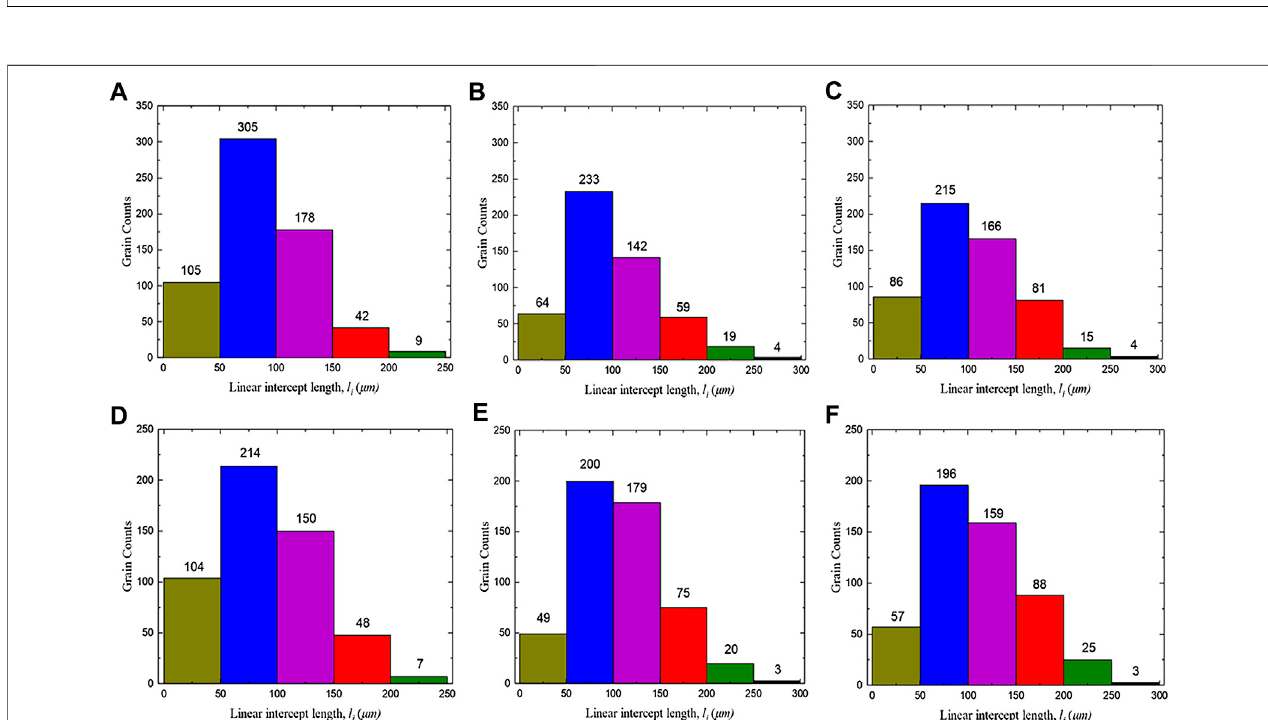
FIGURE 5 | Statistical distribution of sintered UO 2 grain size under different forming pressures. (A) Cr-100 MPa; (B) Cr-200 MPa; (C) Cr-300 MPa; (D) Cr 2 O 3 - 100 MPa; (E) Cr 2 O 3 -200 MPa; (F) Cr 2 O 3 -300